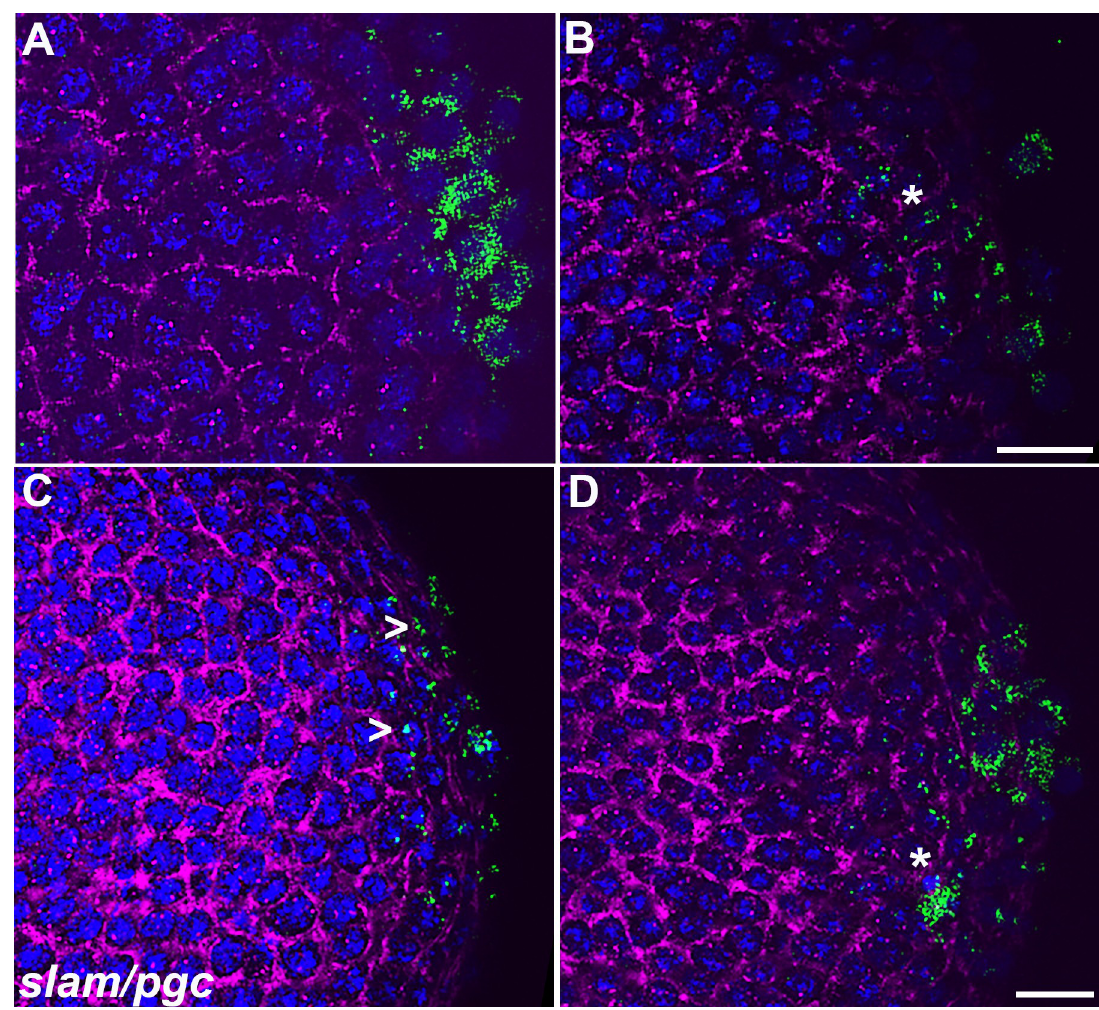
Fig 10. Aberrantly transmitted pgc RNA colocalizes with somatic marker, slam upon simultaneous compromise of oskar and dpp . smFISH was performed using probes specific for pgc (green) and slam (magenta) on 0–4 hr paraformaldehyde-fixed (A/C) osk/+ and (B/ D) dpp hr92 /+;osk/+ embryos to assess spread of pole plasm from the posterior. Caret indicates that some somatic nuclei are exposed to pgc in osk/+ embryos. Asterisk highlights the more severe mislocalization of pgc and overlap of pgc and slam signals in dpp hr92 /+;osk/+ embryos. Images are representative maximum intensity projections Scale bar represents 10 μ